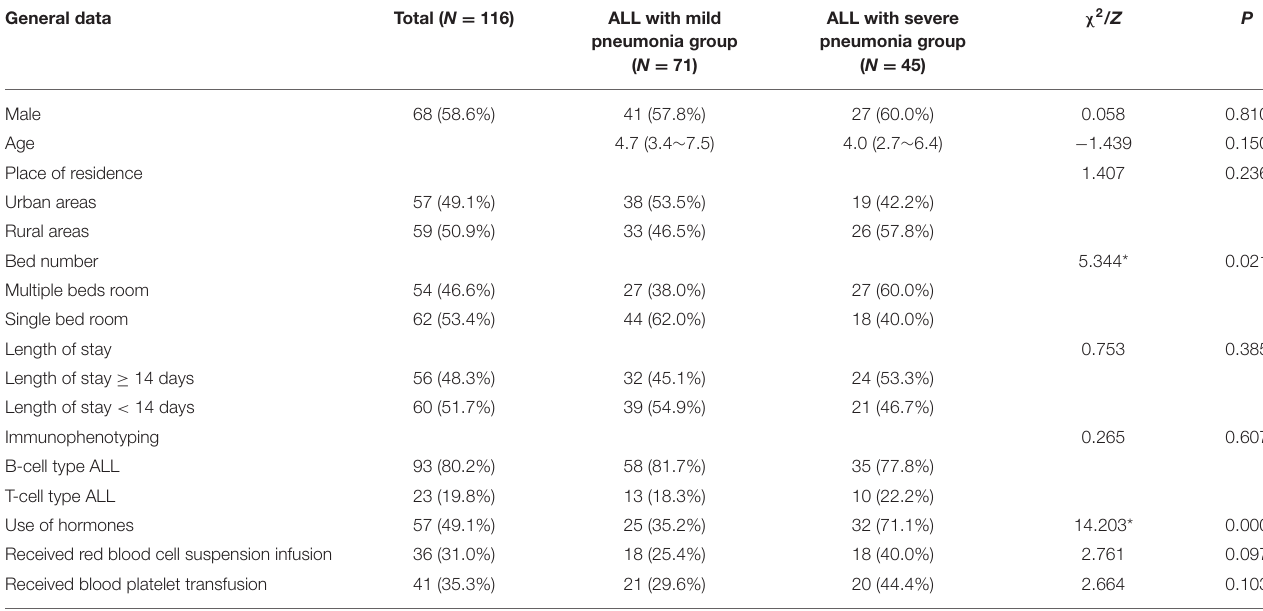
TABLE 1 | Comparison of general data between the ALL with mild pneumonia group and the ALL with severe pneumonia group. General